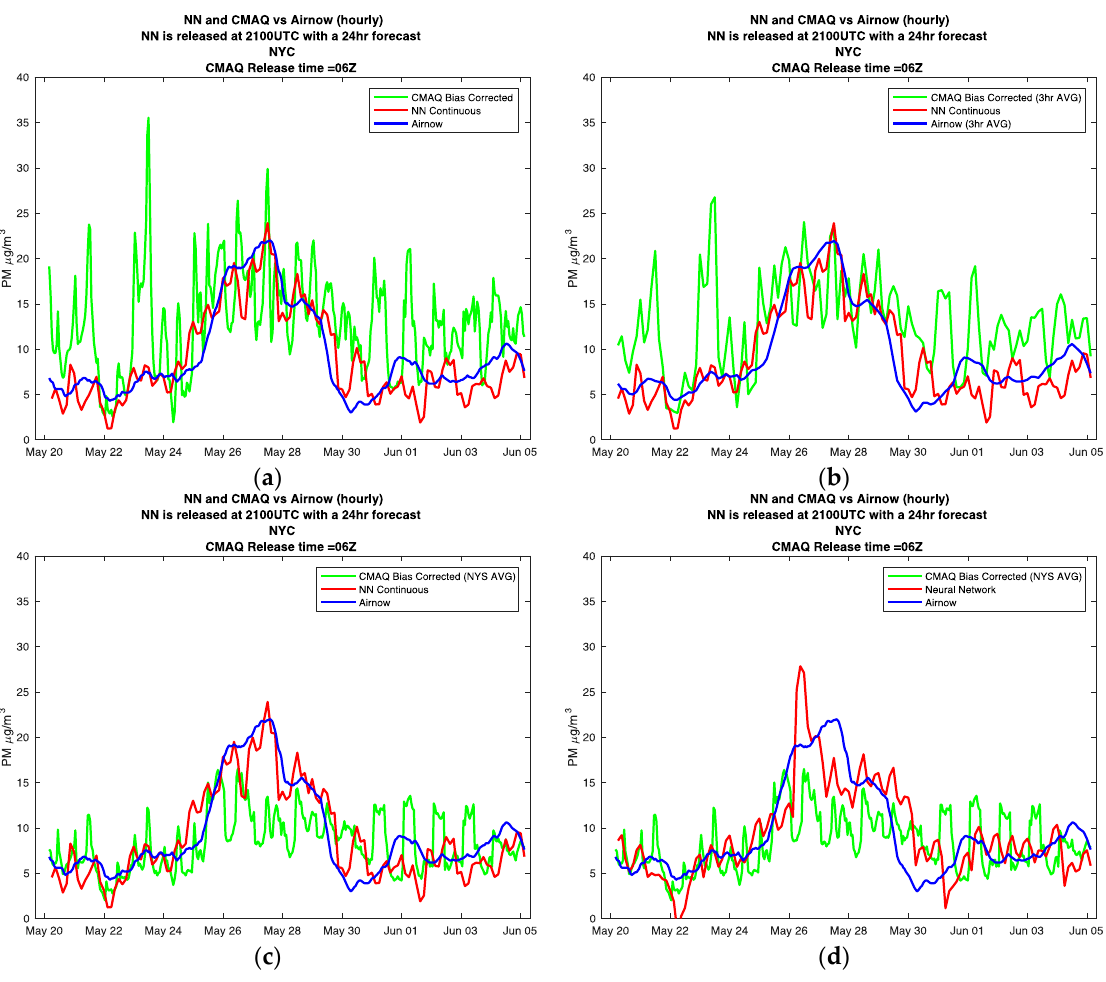
Figure 8. NYC surface PM 2.5 levels affected from the wildfires of Alberta Canada 2016. The plots focus on the aloft plumes mixing down into the PBL on May 25. The plots show different models vs. AirNow observation ( a ) CMAQ Biased hourly, NN continuous; ( b ) CMAQ Biased 3-h average, NN continuous; ( c ) CMAQ Biased state average, NN continuous; ( d ) CMAQ Biased state average, standard Neural Network.